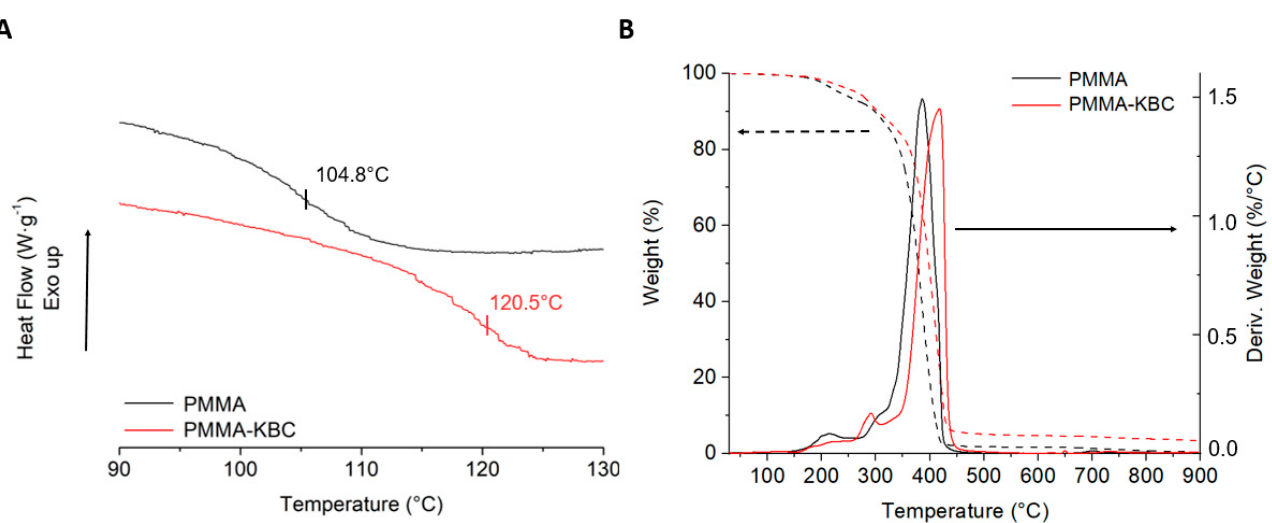
Figure 9. Dynamic mechanical thermal analysis (DMTA) of neat PMMA polymer and PMMA-KBC nanocomposite, storage modulus solid line, and tan δ dashed line as a function of temperature.